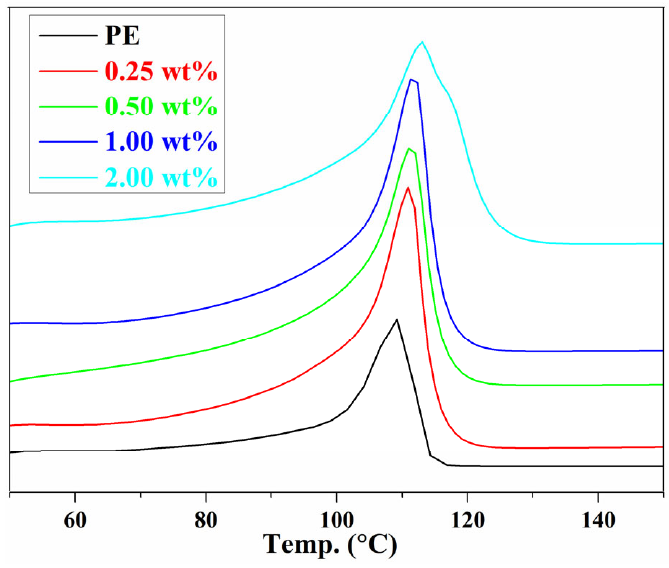
Figure 6. DSC curves of PE and graphene/PE composites.